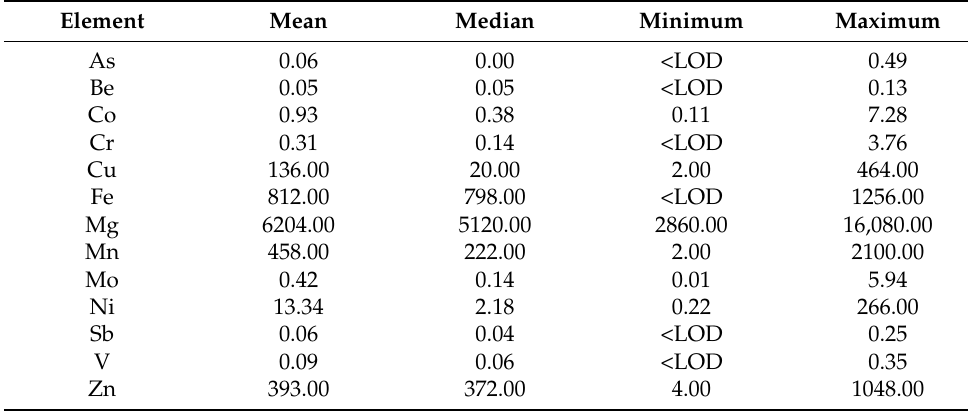
Table 2. Descriptive statistics of PTEs content [ µ g/kg] in honey